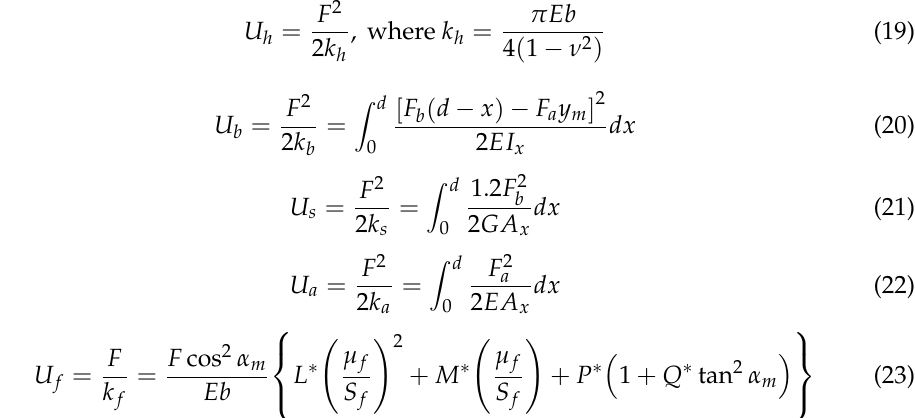
Figure 9. Spur gear slices of helical gear. When the wear occurred on the gear tooth surface, the gear tooth profile will be al- tered as shown in Figure 10, thus the tooth thickness of each spur gear slice will be re- duced. Correspondingly, the coordinate of the meshing point will be changed as well. As a result, the gear mesh stiffness will be affected. In order to more accurately assess the gear mesh stiffness of worn gears, the involute profile of each spur gear slice was up- dated with its corresponding wear depth: (cid:4682)𝑥 (cid:3043) = 𝑟 (cid:3029)(cid:3034) (sin 𝛼 − 𝛼 cos 𝛼) − ℎ (cid:3043),(cid:3041) sin 𝛼 (cid:3040) 𝑦 (cid:3043) = 𝑟 (cid:3029)(cid:3034) (cos 𝛼 + 𝛼 sin 𝛼) − ℎ (cid:3043),(cid:3041) cos 𝛼 (cid:3040)